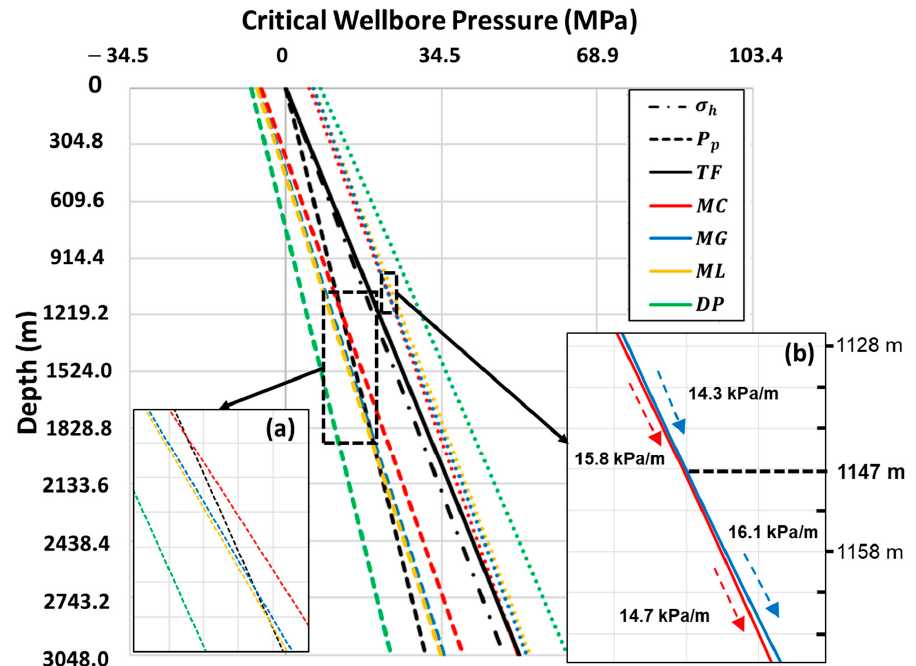
Figure 6. Normal faulting regime—extensional basin. Critical wellbore pressure at lower- (colored dashed), upper-bound shear (colored solid), and tensile (TF; black solid) failures under the normal faulting case with the vertical, maximum and minimum horizontal stress gradients of 22.6, 20.4, and 15.8 kPa / m, respectively. The pore pressure gradient is 10.2 kPa / m (black dashed). The wellbore pressures were calculated by the Mohr–Coulomb (MC; red), Mogi–Coulomb (MG; blue), modified Lade (ML; yellow), and Drucker–Prager (DP; green) failure criteria. The minimum horizontal in-situ stress is depicted with the dash-dotted black line. The magnified frame ( a ) indicates that the calculated lower critical wellbore pressures exceed the pore pressure at certain depths. The magnified frame ( b ) shows the alteration of the upper critical wellbore pressure gradient calculated by the Mohr–Coulomb (red) and Mogi–Coulomb (blue) criteria.